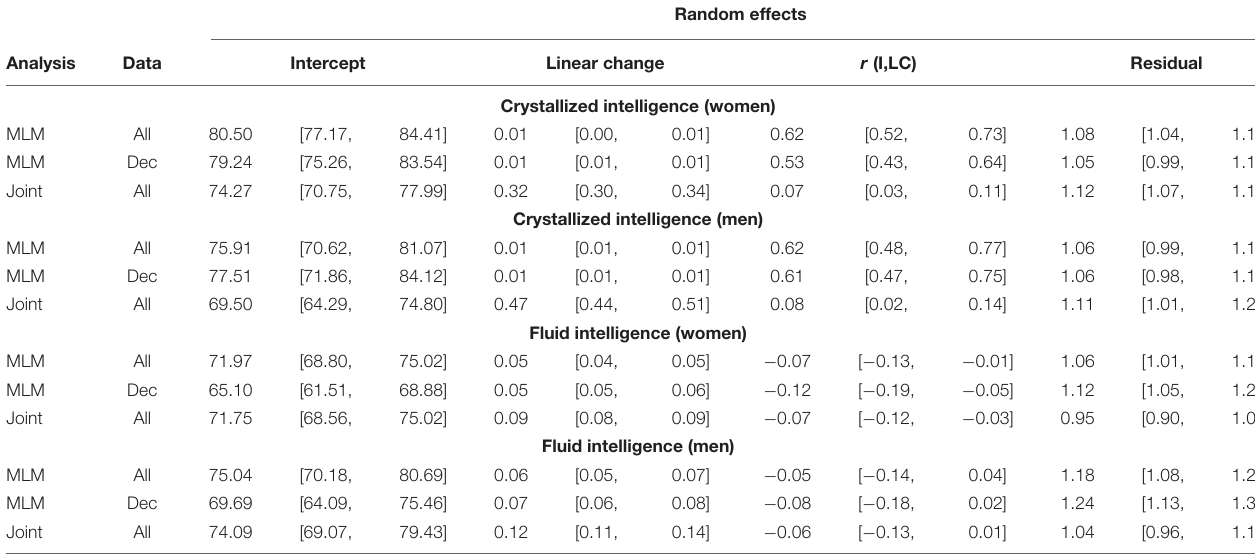
TABLE 4 | Random effects from quadratic change models (unadjusted).